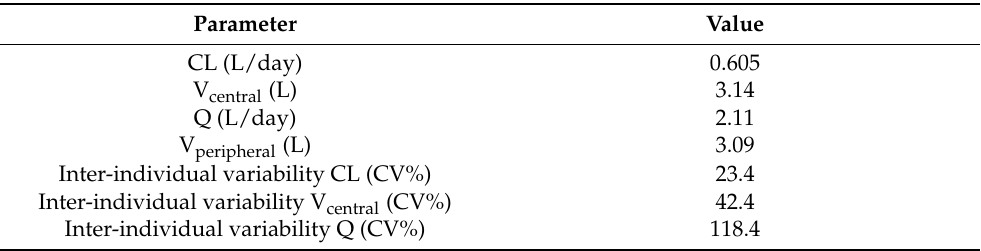
Table 3. Pharmacokinetic parameters of each individual AAT patient after applying the pharmacoki- netic